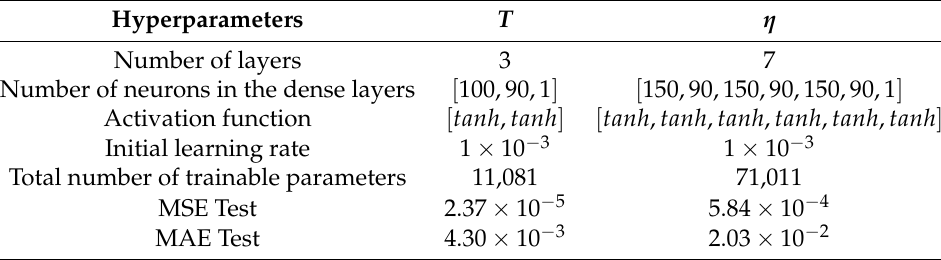
Table 7. Resulting network